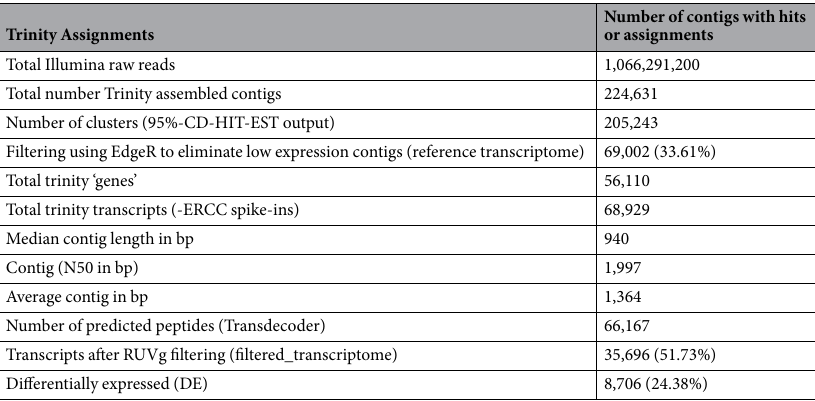
Control Consortium (ERCC) assembly of 92 spike-in controls 37 in the normalization procedure. RUVg anal- ysis assessed two parameters: (1) the estimated factors of unwanted variation and (2) the normalized counts obtained by regression of the original counts on the unwanted factors. There were substantial library preparation effects for un-normalized counts (Suppl. Figure 1A,B). These were only attenuated (and not fully removed) by upper-quartile normalization (Suppl. Figure 1C,D). By contrast, RUVg reduced library preparation effects (Suppl. Figure 1E,F). After RUVg filtering, we were left with 35,696 genes (Table 2) and 42 ERCC spike-ins (Fig. 2). This dataset was designated as the filtered transcriptome (YO/I/DRESA_filtered). Both count and FPKM values (fragments per kilobase of contig per million fragments mapped) were positively correlated between replicates (P = 0.81–0.99), indicating that the normalization protocols controlled for potential library preparation artifacts and allowed for interlibrary comparisons (Table 3). If gene expression differences exist among experimental con- ditions, it is expected that biological replicates of the same condition will cluster together in a principal compo- nent analysis (PCA) (Suppl. Figure 1F). Pearson coefficients were calculated in a pairwise statistical analysis of count and FPKM values (Table 3). In general, the biological replicates clustered in the same treatments and times, with PC1 explaining 49.5% of the variation and PC2 explaining another 11.8% of the variation after normaliza- tion (Suppl. Figure 1F). In this analysis, one of the intermolt library replicates (I1) was observed as an outlier, as the correlation coefficient value was less than 0.6. Since this replicate remained an outlier following normalization (Suppl. Figure 1D,F and Table 3), it was excluded from differentially expressed gene analysis (DEG) of the dataset.